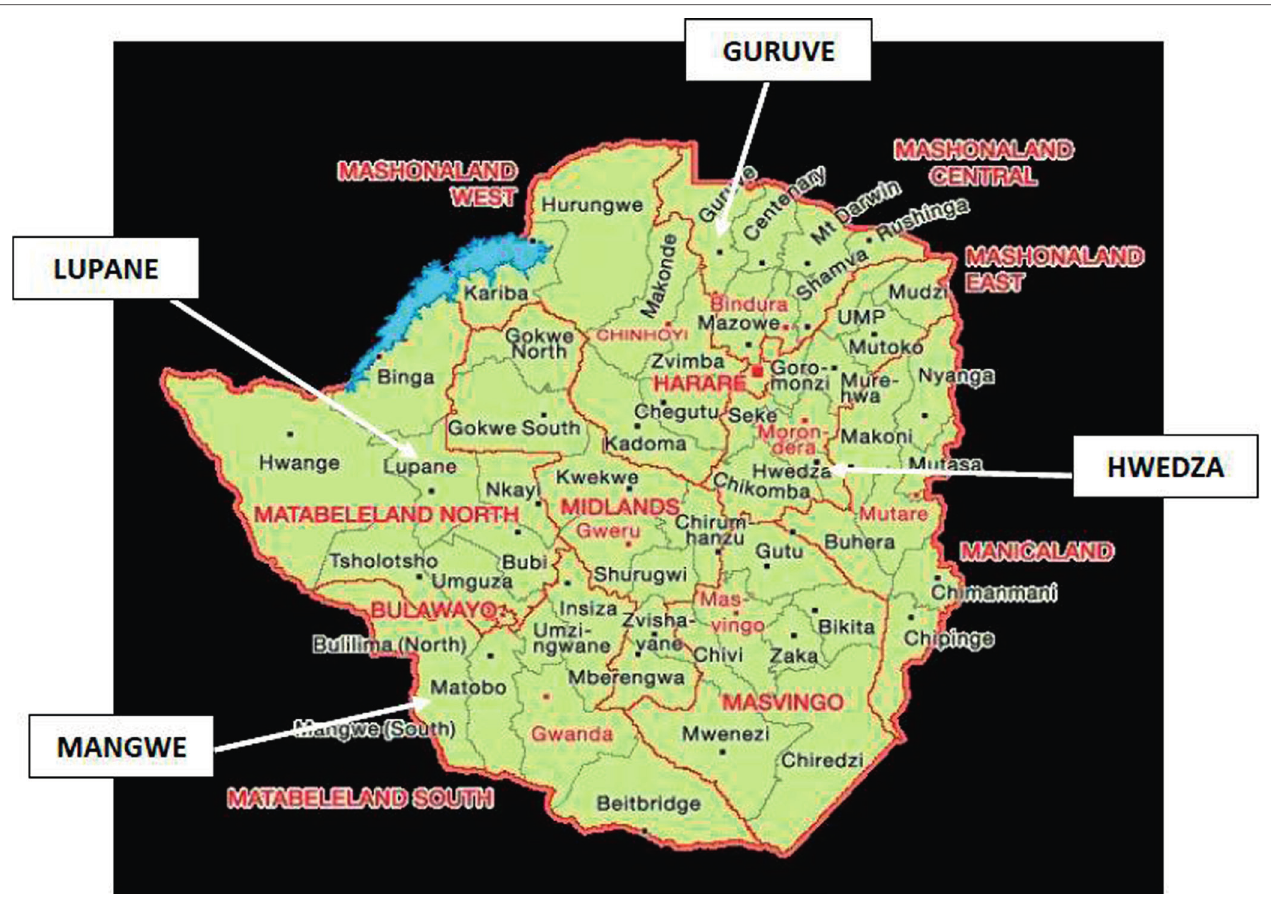
FIGURE 1: Map of Zimbabwe showing the four districts of